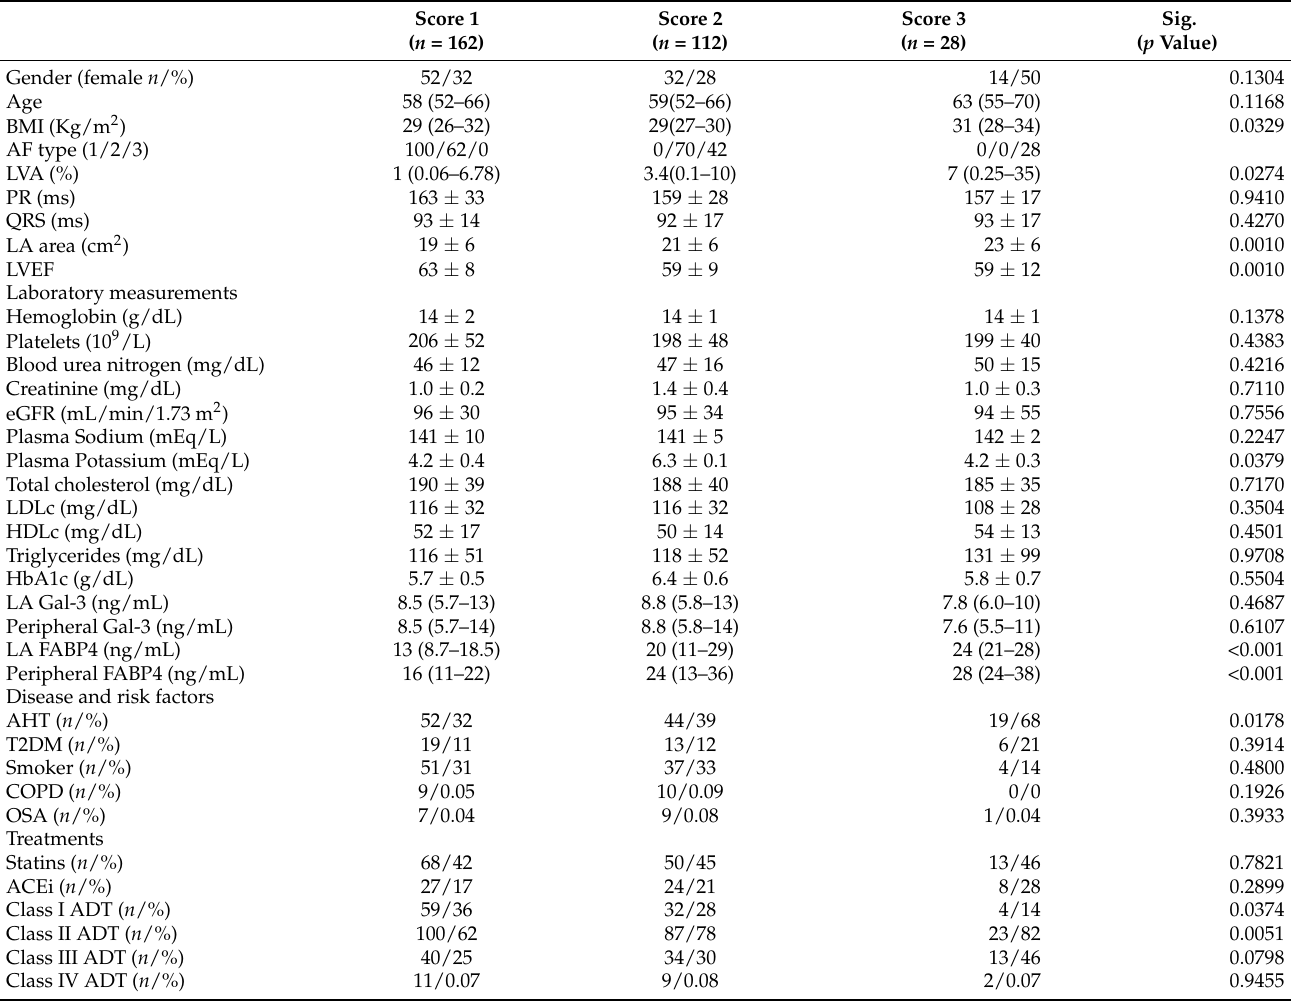
Table 3. Clinical characteristics of patients regarding score (AF type plus FABP4